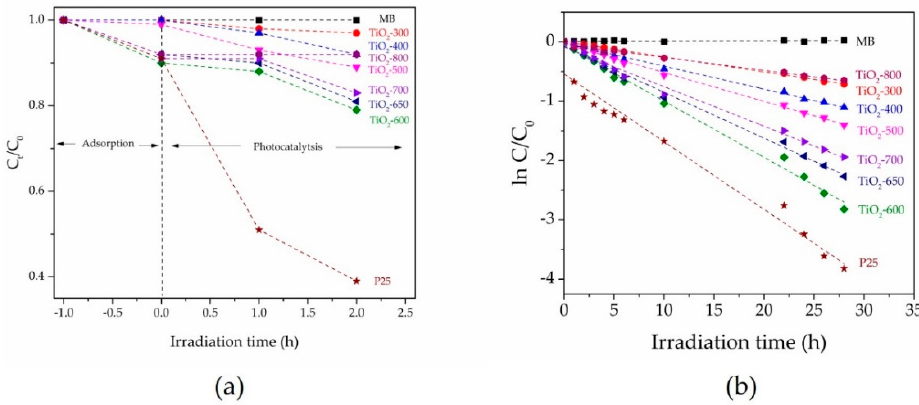
Figure 5. ( a ) The adsorption change of methylene blue (MB) in the dark and photocatalytic degradation of MB under UV light for 2 h with the synthesized TiO 2 and P25. ( b ) Photocatalytic degradation of MB under UV light obtained when using synthesized TiO 2 with different calcination temperatures. Table 3. Kinetic constant (k) of MB degradation obtained when using synthesized TiO 2 powder with different calcination temperatures.